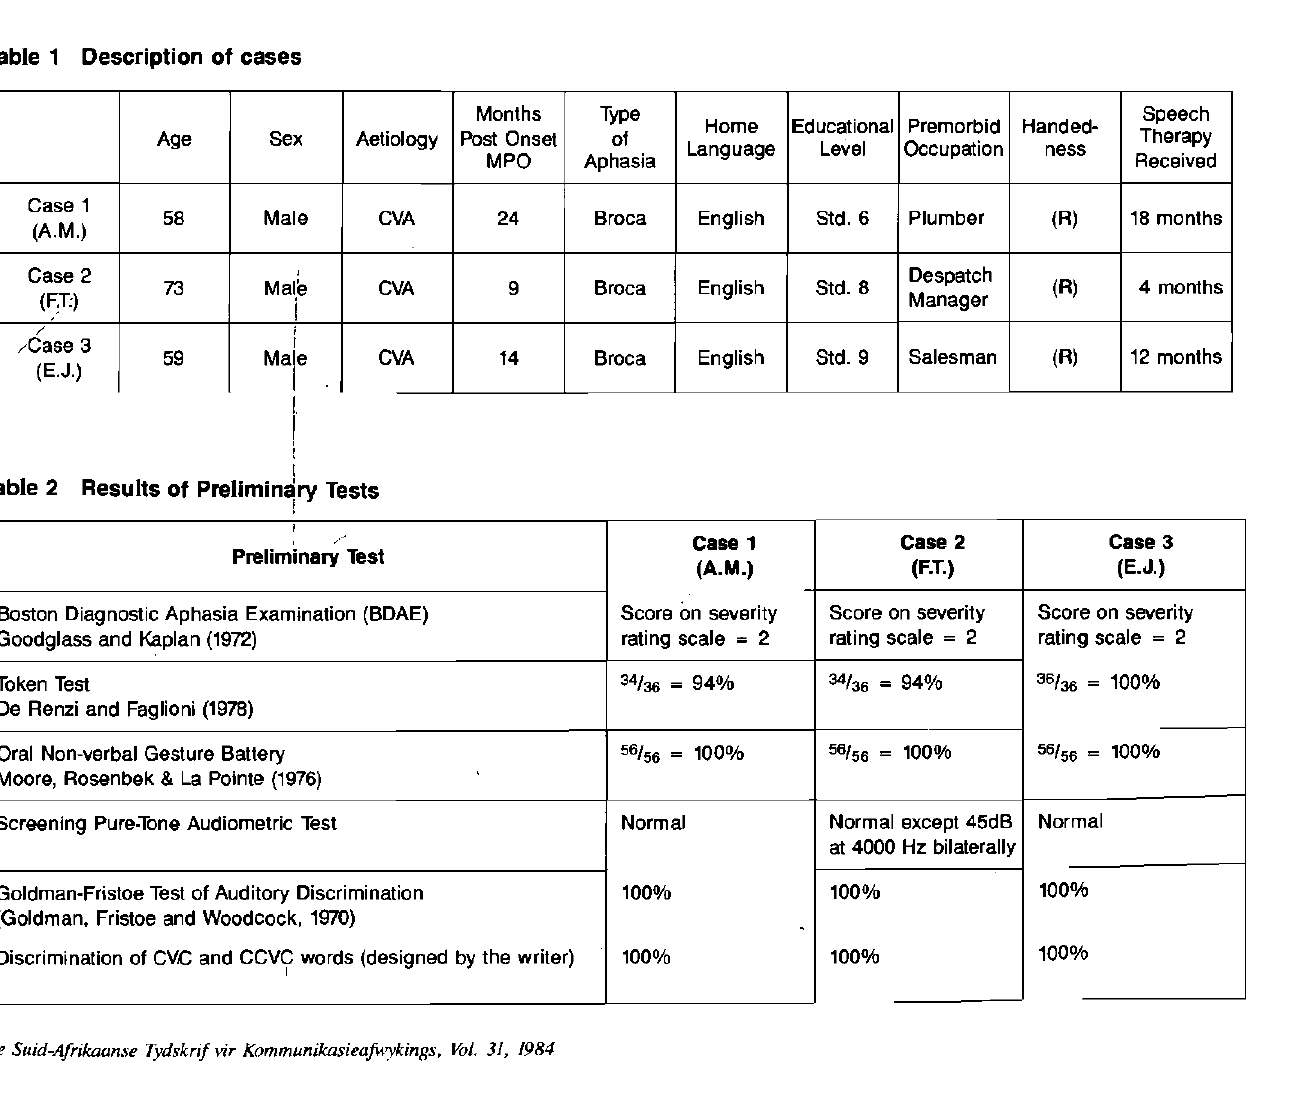
Table 2 Results of Preliminary